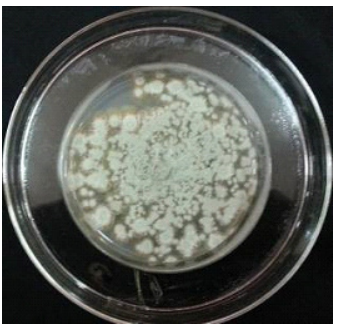
Fig. 8 (B). Mycelium growth of Penicillium italicum After adding 5 ml of distilled water (in the outer dish) and incubated it for one week at